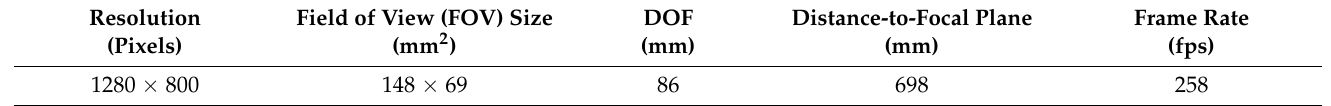
Table 2. Summary of primary parameters in the high-speed photography for PIV measurement.